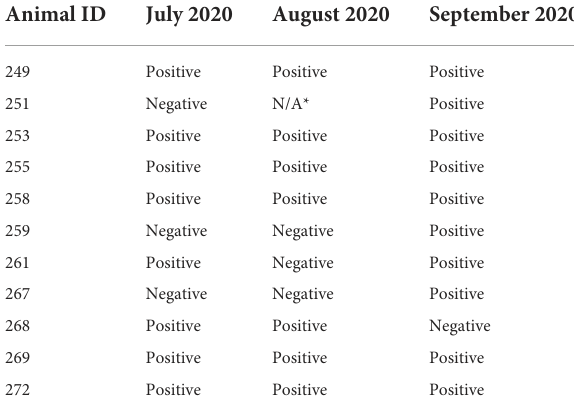
TABLE 3 Results of Borrelia testing in the eland antelope during a 3-month sampling period. Animal